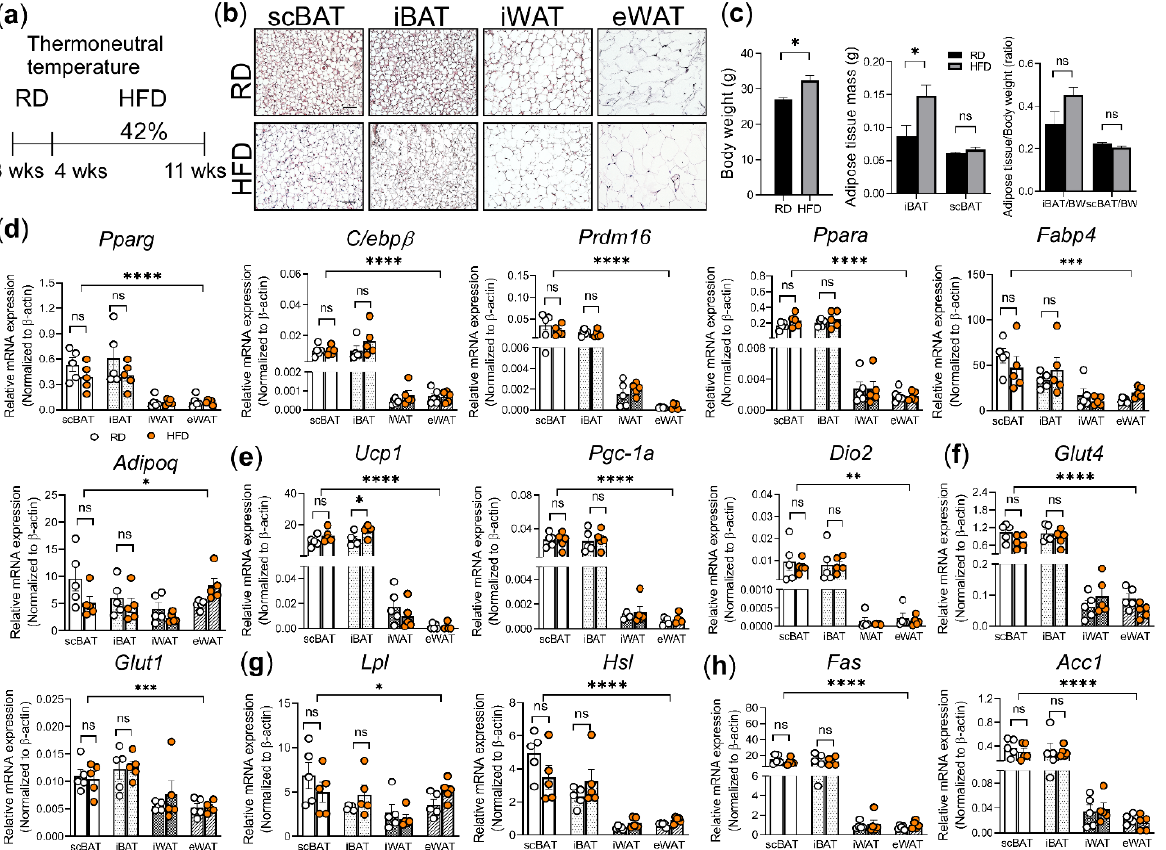
Figure 4. The effect of HFD on the adipocyte morphology and gene expression in scBAT, iBAT, iWAT, and eWAT under thermoneutrality. ( a ) Schematic diagram of the thermoneutral housing study design under HFD. 3-week-old mice were housed at 28 °C for 8 weeks. Mice were fed with RD for 1week for adaptation and then fed with HFD for an additional 7 weeks. ( b ) Representative images of H&E-stained sections of scBAT, iBAT, iWAT, and eWAT from mice fed RD or HFD under thermoneutral temperatures. n = 5. Scale bar = 50 µm. ( c ) Body weight, adipose tissue mass, and ratio of adipose tissue to body weight of mice described in B (RD, n = 5 and HFD, n = 5). ( d – h ) RT-qPCR analysis of adipocyte differentiation marker genes, thermogenic genes, glucose uptake genes, and lipid processing genes, and lipogenesis genes in scBAT, iBAT, iWAT, and eWAT depots from mice housed under ambient and thermoneutral temperatures. ( d ) Adipocyte differentiation markers, Pparg , C/ebpβ , Prdm16 , Pparα , Fabp4 , and Adipoq . ( e ) Thermogenic genes, Ucp1 , Pgc-1α , and Dio2 . ( f ) Glucose transporters, Glut4 and Glut1 . ( g ) Lipid uptake and processing genes, Lpl and Hsl . ( h ) Lipogenesis genes, Fas , Acc1 . The expression of these genes is normalized to the housekeeping gene β-actin. Data are presented as mean ± SEM. n = 5 for each group. * p < 0.05, ** p < 0.01, *** p < 0.001, **** p < 0.0001, ns = nonsignificant.